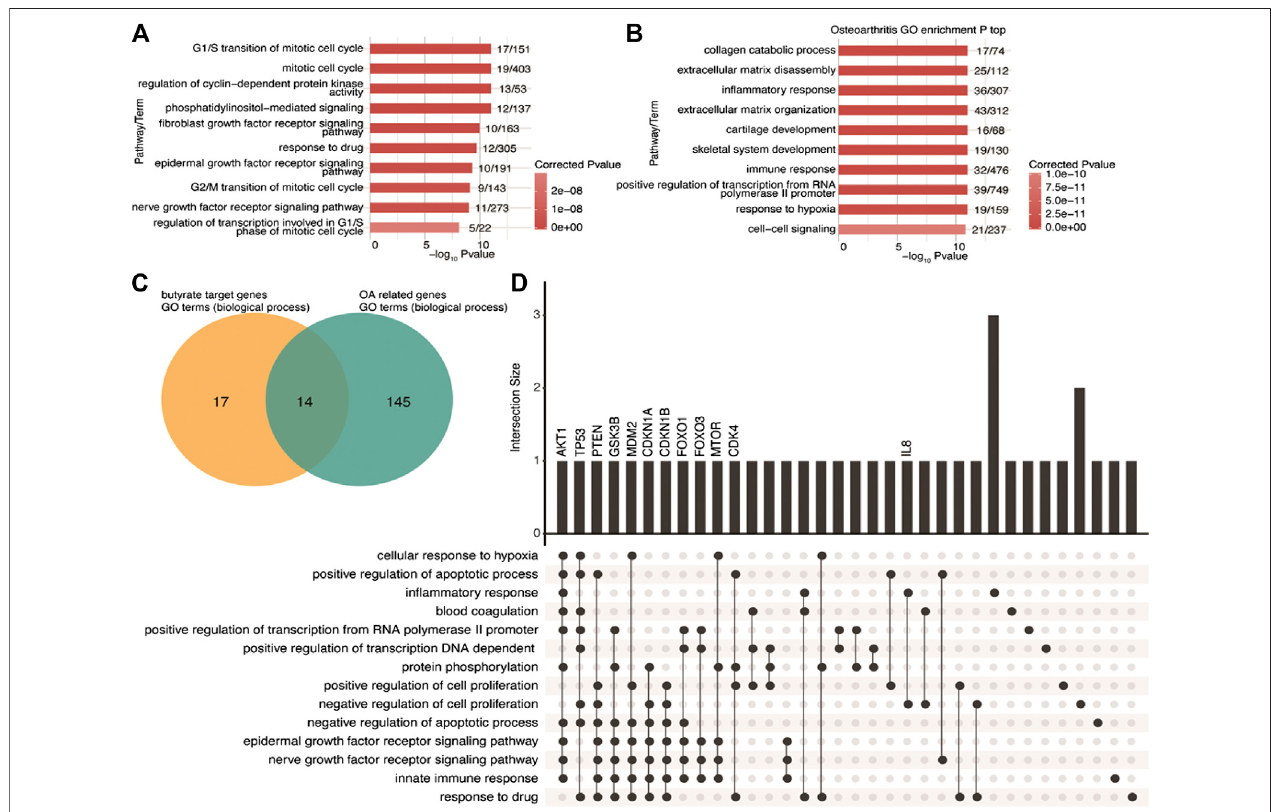
FIGURE 1 | GO biological process terms shared between butyrate-targeted genes and OA-related genes (A,B) Top 10 most-enriched GO terms (biological process) for butyrate-targeted genes and OA-related genes. (C) Venn diagram showing the overlapping GO terms (biological process) enriched by both butyrate- targetedgenesandOA-related genes. (D) Visualizationoftheintersection sizeofthebutyrate-targetedgenesinvolvedinsharedGOtermsin C .GO,geneontology;OA, osteoarthritis.